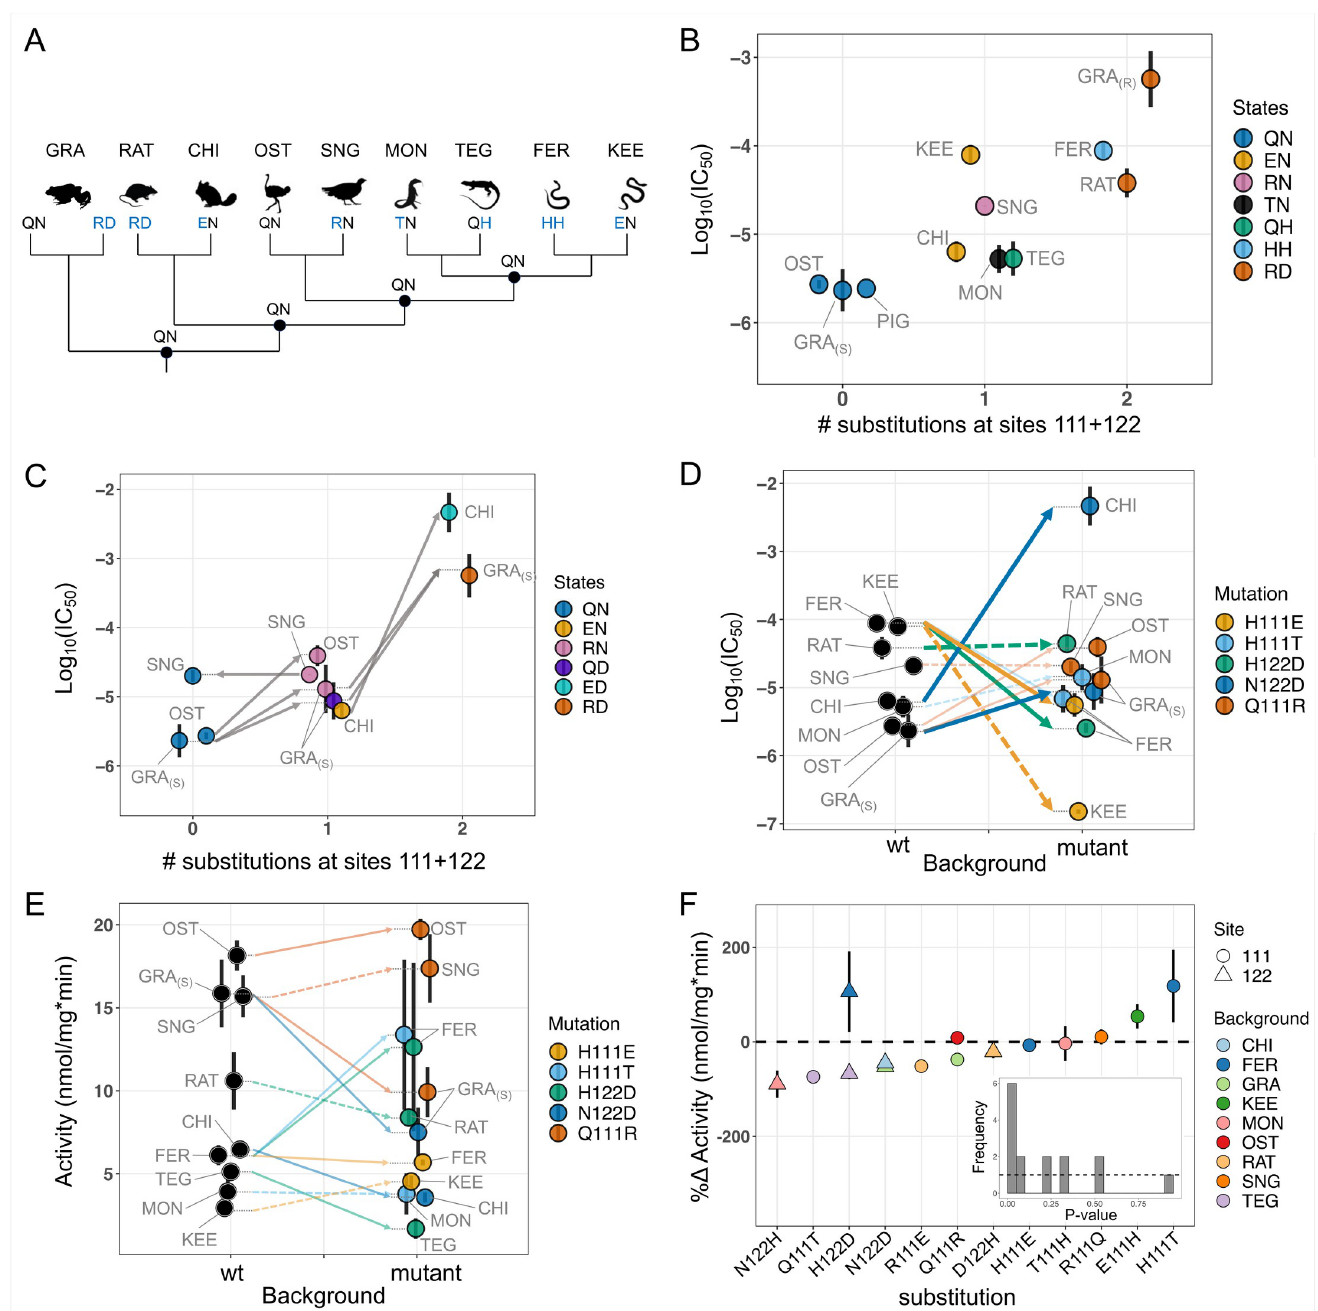
Fig 4. Functional properties of wild-type and engineered ATP1A1. (A) Cladogram relating the surveyed species. GRA: Grass Frog ( Leptodactylus ); RAT: Rat ( Rattus ); CHI: Chinchilla ( Chinchilla ); OST: Ostrich ( Struthio ); SNG: Sandgrouse ( Pterocles ); MON: Monitor lizard ( Varanus ); TEG: Tegu lizard ( Tupinambis ); FER: False fer-de-lance ( Xenodon ); KEE: Red-necked keelback snake ( Rhabdophis ). Two-letter codes underneath each avatar indicate native amino acid states at sites 111 and 122, respectively. Data for grass frog are from Mohammadi et al. [26]. (B) Levels of CTS resistance (IC 50 ) among wild-type enzymes. The x-axis distinguishes among ATP1A1 with 0, 1 or 2 derived states at sites 111 and 122. The subscripts S and R refer to the CTS-sensitive and CTS-resistant paralogs of grass frogs (GRA), respectively. (C) Effects on CTS resistance (IC 50 ) of changing the number of substitutions at 111 or 122. Substitutions result in predictable changes to resistance except in the reversal R111Q in Sandgrouse (SNG). (D) Evidence for epistasis for CTS resistance (IC 50 ) and (E) lack of such effects for enzyme activity. Each colored arrow compares the same substitution (or the reverse substitution) tested on at least two backgrounds. Thicker lines correspond to substitutions with significant sequence-context dependent effects (Bonferroni-corrected ANOVA p -values < 0.05, S5 Table). Dashed arrows correspond to the reverse substitutions. (F) Effects of single substitutions on Na,K-ATPase (NKA) activity. Each modified ATP1A1 is compared to the wild-type enzyme for that species. The inset shows the distribution of t -test p-values for all 15 substitutions, with the dotted line indicating the null expectation. In all cases, error bars correspond to standard errors for three replicates. For panels B, C, D and E, jitter was applied to datapoints to ease visualization. https://doi.org/10.1371/journal.pgen.1010323.g004 PLOS Genetics | https://doi.org/10.1371/journal.pgen.1010323 August 16,